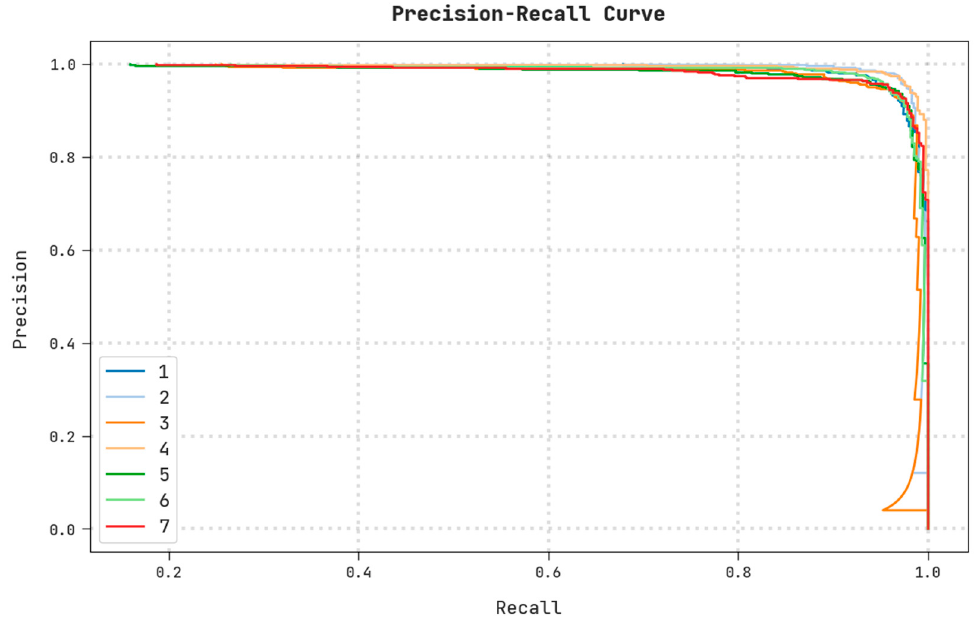
Figure 9. Precision-recall analysis of CLBEDC-SND approach.